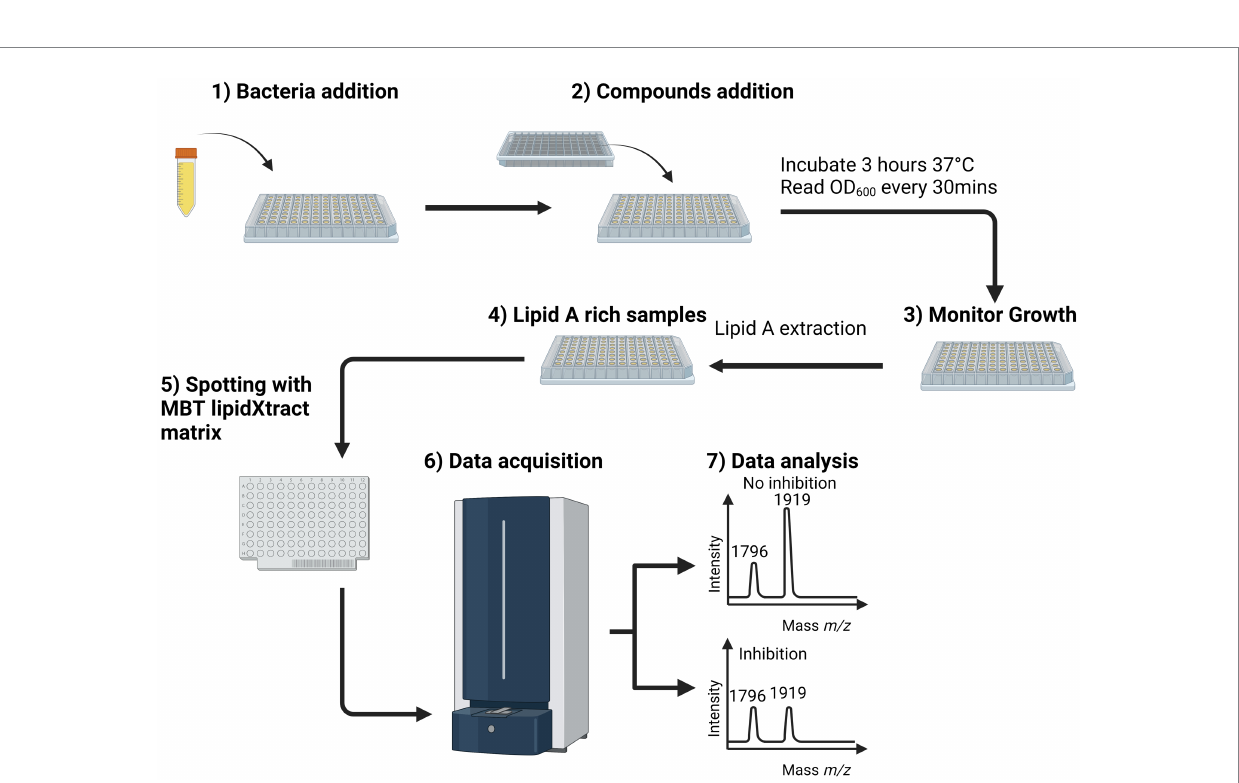
FIGURE 1 MALDI-TOF MS-based lipidomics screening workflow for whole-cell bacteria assays. After bacterial addition (overnight culture diluted 1/100) (1), the natural compounds were added at a predetermined final concentration (2), and the suspension was incubated for 3 h at 37 ° C in a spectrometer to monitor the optical density at 600 nm every 30 min (3). Once the measurements were complete, the bacterial suspensions were submitted to lipid A extraction (Jeannot et al., 2017), and the results of that process were spotted onto a MALDI target plate with MBT Lipid Xtract matrix (5). The MALDI target plate was introduced into the MALDI Biotyper Sirius system, and the samples were analyzed in linear negative ion mode (6). In the mass spectrum, active and inactive compounds can be distinguished based on the observed value of the ratio. Using this workflow, the total time to screen a plate containing 96 compounds was ~4 h, of which 3 h was needed for growth of the bacteria in presence of the compound of interests and ~ 1 h to process and acquire the samples for lipid A analysis by MALDI-ToF MS. Calculated by Equation 1